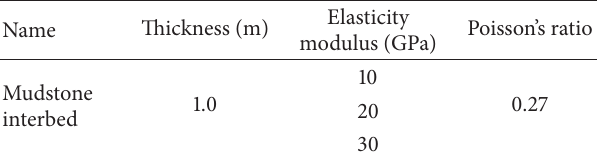
Table 4: No. 2 simulation scheme.